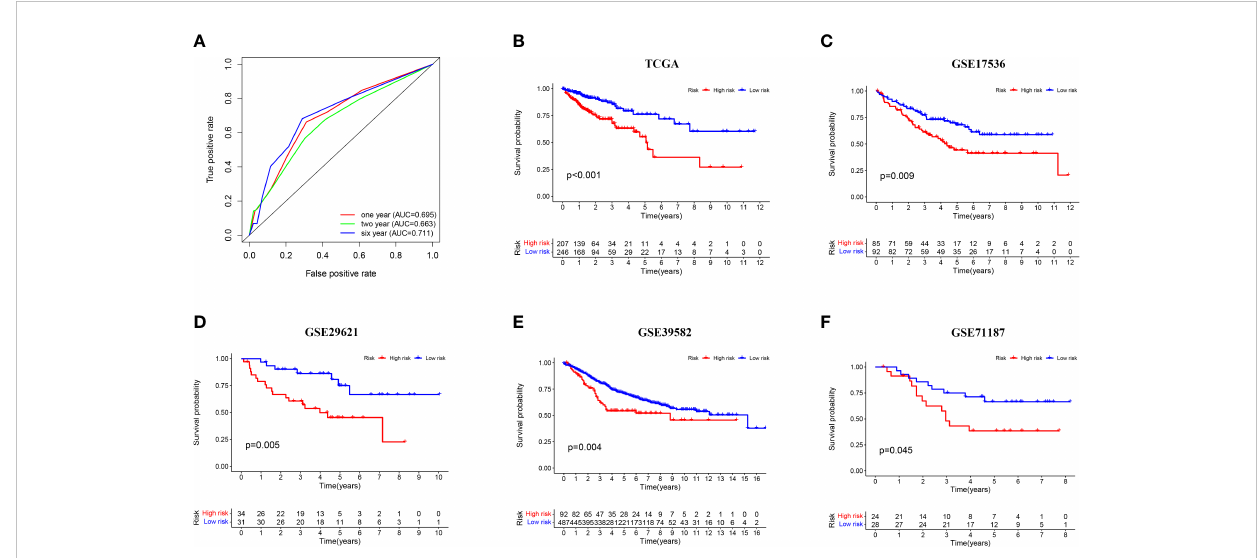
FIGURE 3 Prognostic validation of risk signature. (A) Time-dependent ROC curve analysis for the TCGA-CRC dataset; (B – F) Kaplan – Meier survival analysis of the risk signature in the TCGA-CRC training set and four independent validation sets (GSE17536, GSE29621, GSE39582, and GSE71187).